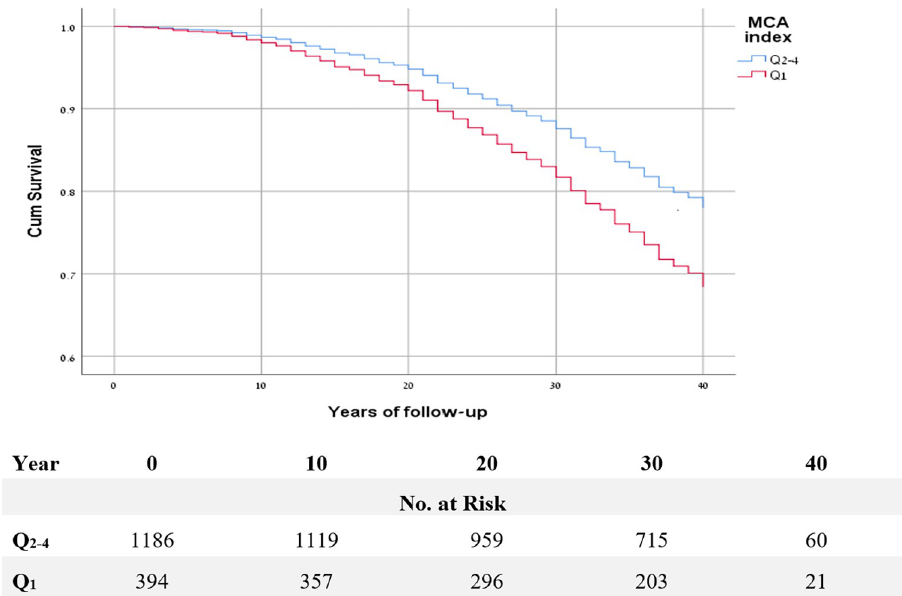
Fig 1. Adjusted a survival curves using the Cox proportional hazard model, according to the Mcauley index low vs. higher quartiles for cancer mortality. a Adjusted for: age, sex, origin, BMI, systolic blood pressure, cholesterol, smoking and diabetes status. Mean survival time for malignancy associated mortality in the lower (higher insulin resistance) MCA quartile (Q 1 ) was 35.8 (95%CI, 34.9–36.7) years and 36.9 (95%CI, 36.5–37.4) years in the upper (lower insulin resistance) MCA quartiles (Q 2-4 ), p = 0.02. Censoring occurred at time of other non-cancer death or end of